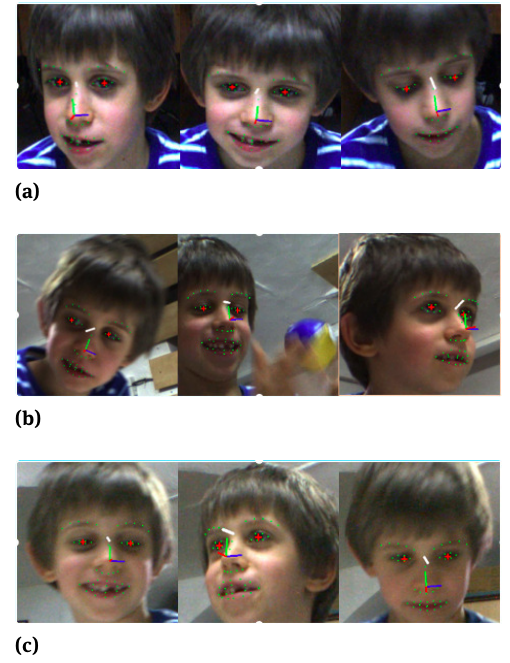
Figure 6: Gaze estimation results on an ASD child recorded from intervention table. The white line denotes the gaze direction.